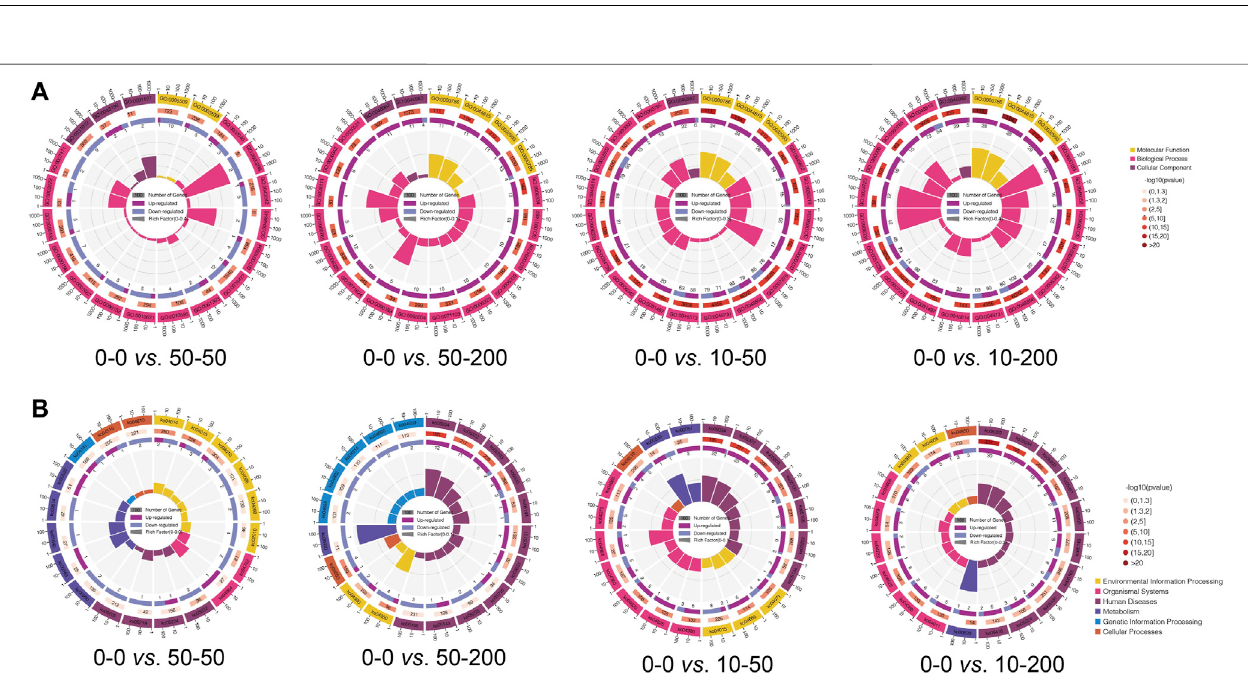
FIGURE 7 | GO and KEGG pathway analysis. (A) Circle diagram of top 20 of GO enrichment. (B) Circle diagram of top 20 of KEGG enrichment.